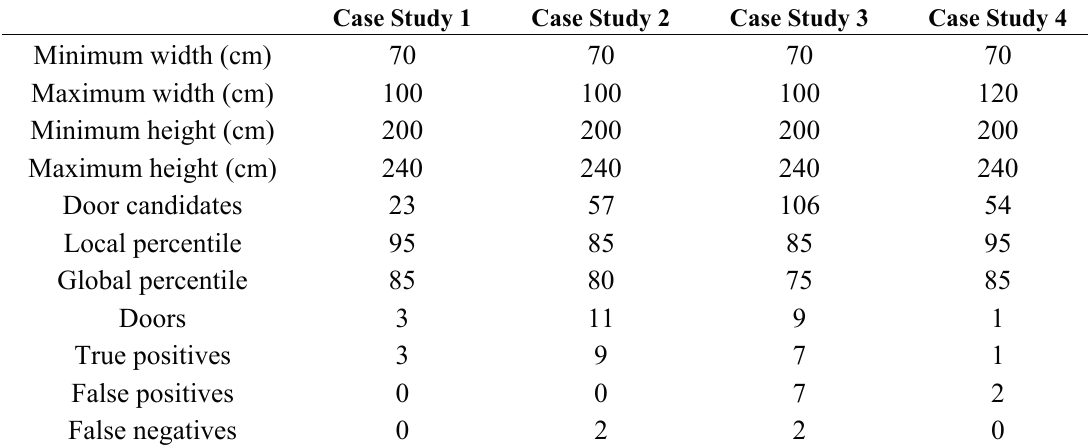
Figure 16. Two door examples from case study 3 ( up ) and case study 4 ( down ): the input orthoimages ( left ); the resulting edge images after horizontal and vertical edge pixel selection ( medium ) and the door candidates detected ( right ). Table 6. True positives, false positives and false